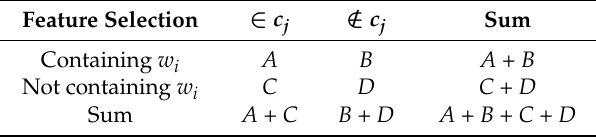
Table 2. Different cases of the sums of the